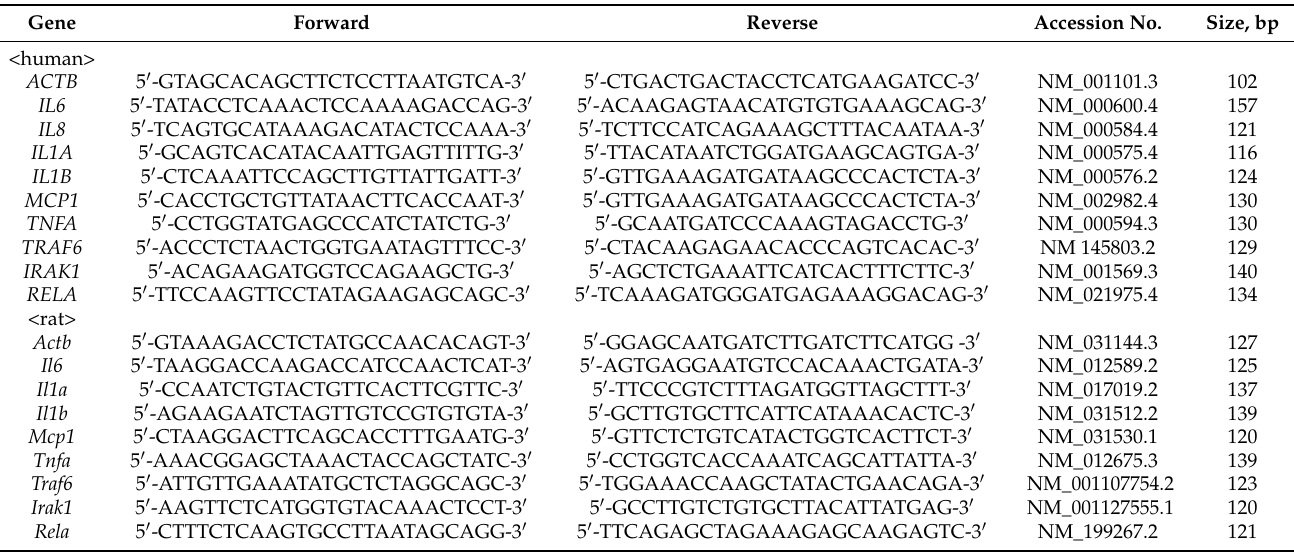
Table 1. Sequence for primers used in